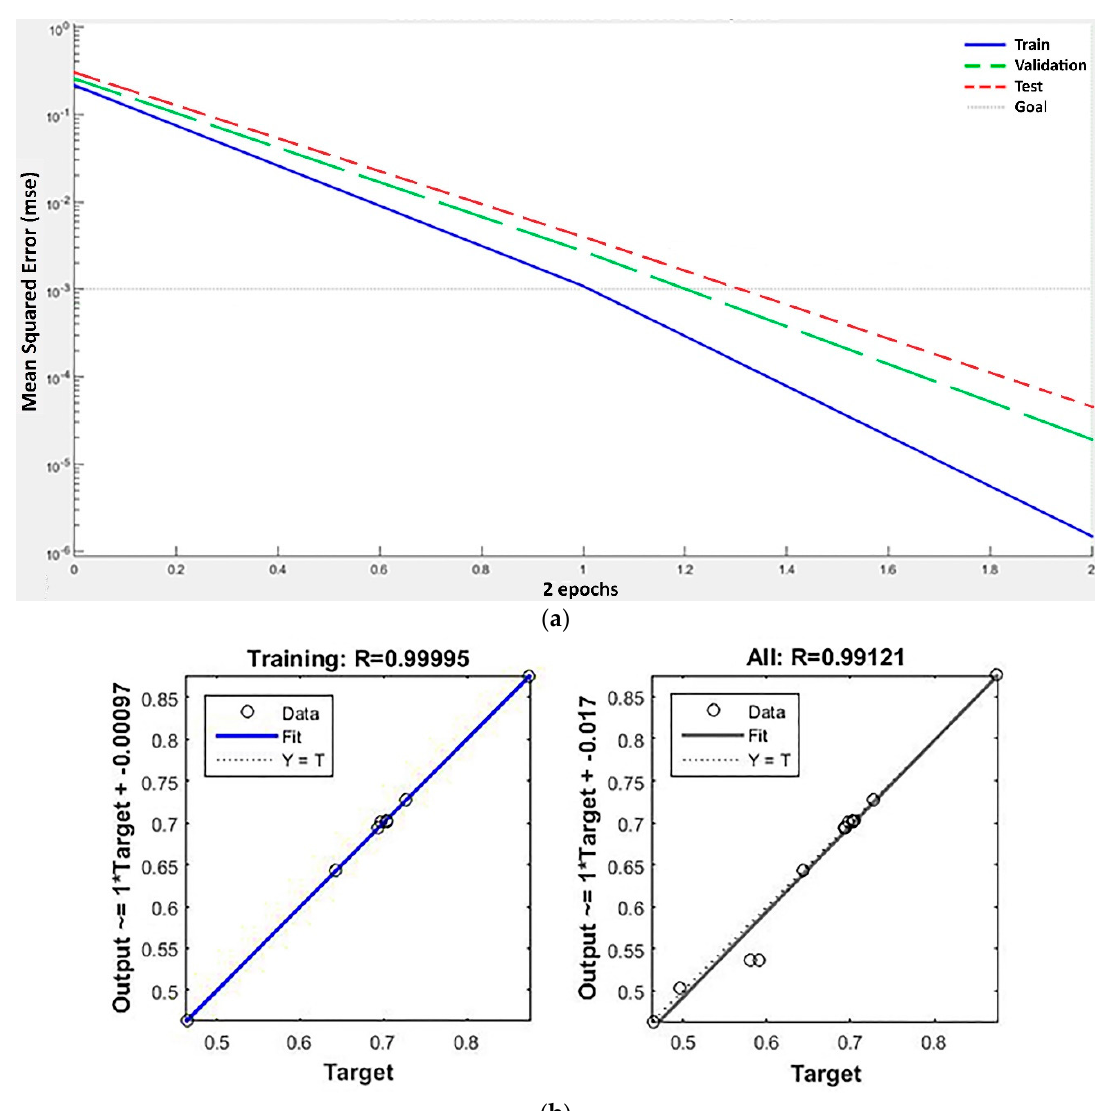
Figure 2. The selected neural model 4-17-1: ( a ) The network performance: MSE vs. iterations; ( b ) regression plots: the actual output vs. the targets for the training dataset (left) and for all data (right).